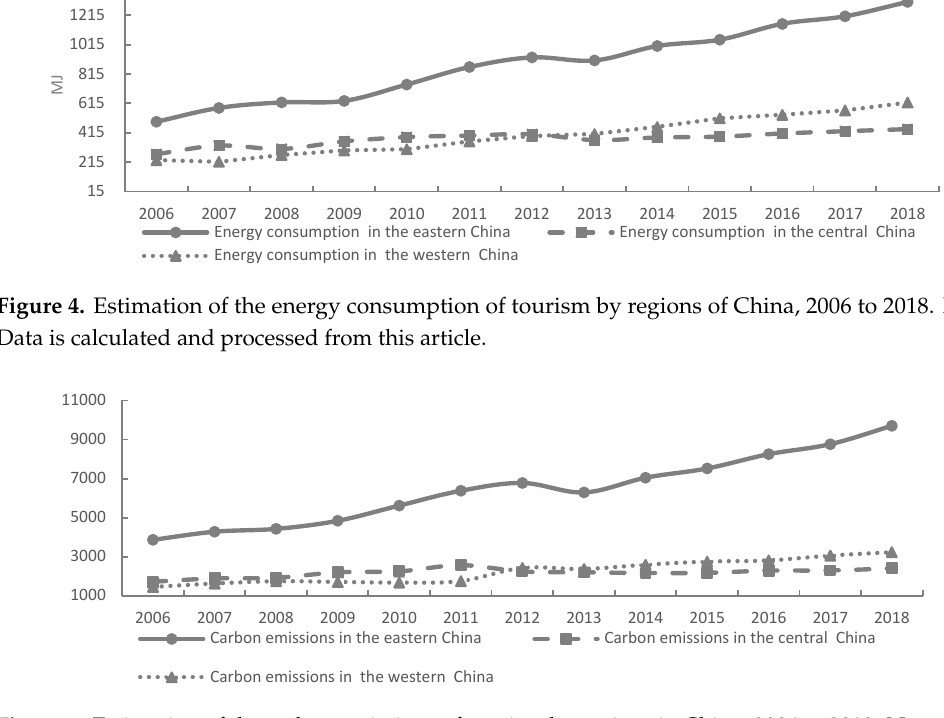
Figure 5. Estimation of the carbon emissions of tourism by regions in China, 2006 to 2018. Note: Data is calculated and processed from this